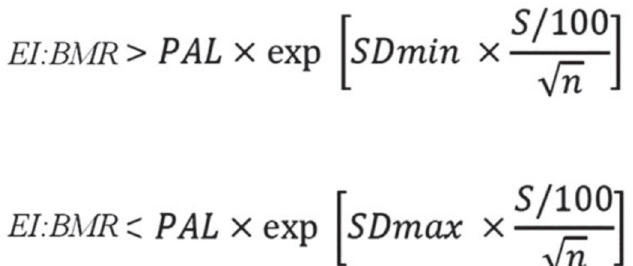
Figure 1. Goldberg/Black equation to derive cut-off values for evaluation of misreporting of energy intake [22]. Legend: EI: Energy intake; BMR: Basal metabolic rate; PAL: Physical activity level; S: Coe ffi cient that considers the variation in EI, BMR and PAL; SDmin: − 2 for the 95% lower confidence